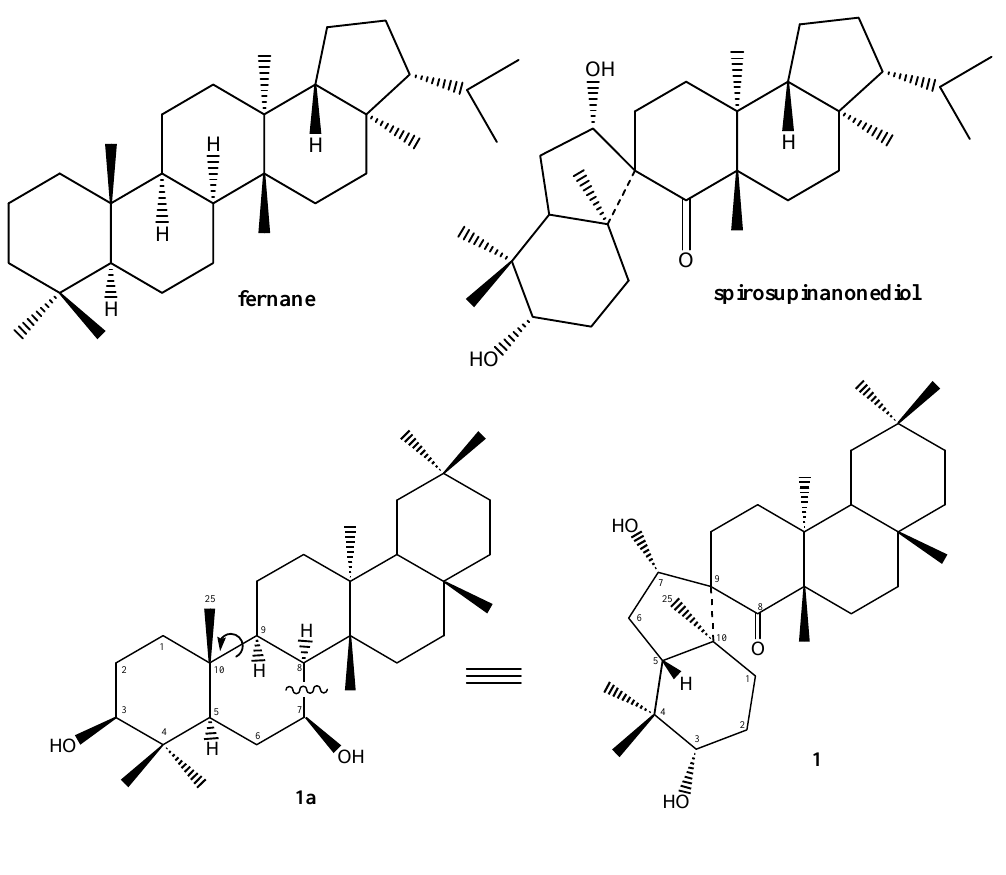
Figure 1. Fernane/spirosupinanonediol relationship and possible multiflorane ( 1a ) to spirowallichiione ( 1 )